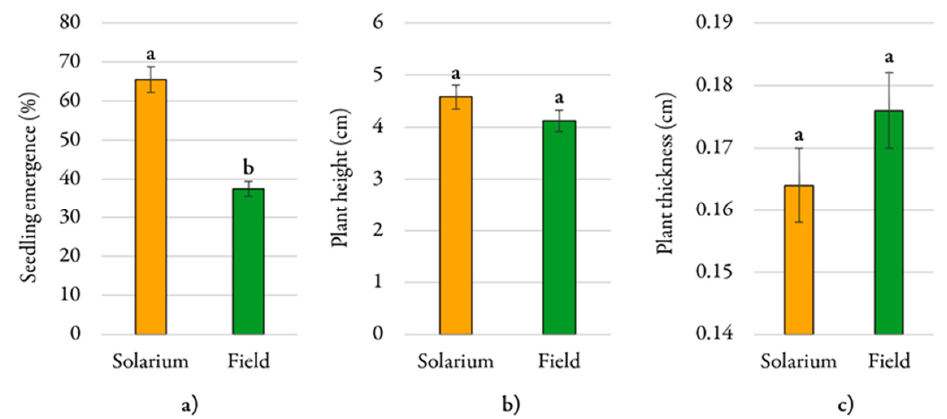
Figure 6. Comparison of the values of seedlings’ emergence (a), plant height (b) and plant thickness (c), in two different conditions: solarium and field (as mean ± SE) Seedlings were measured one month after sowing the seeds from selected plus trees T-test for two-sample assuming equal variances, α = 0.05; p- value: 0.0001 (seedling emergence); 0.3071 (plant height); 0.6533 (plant thickness)